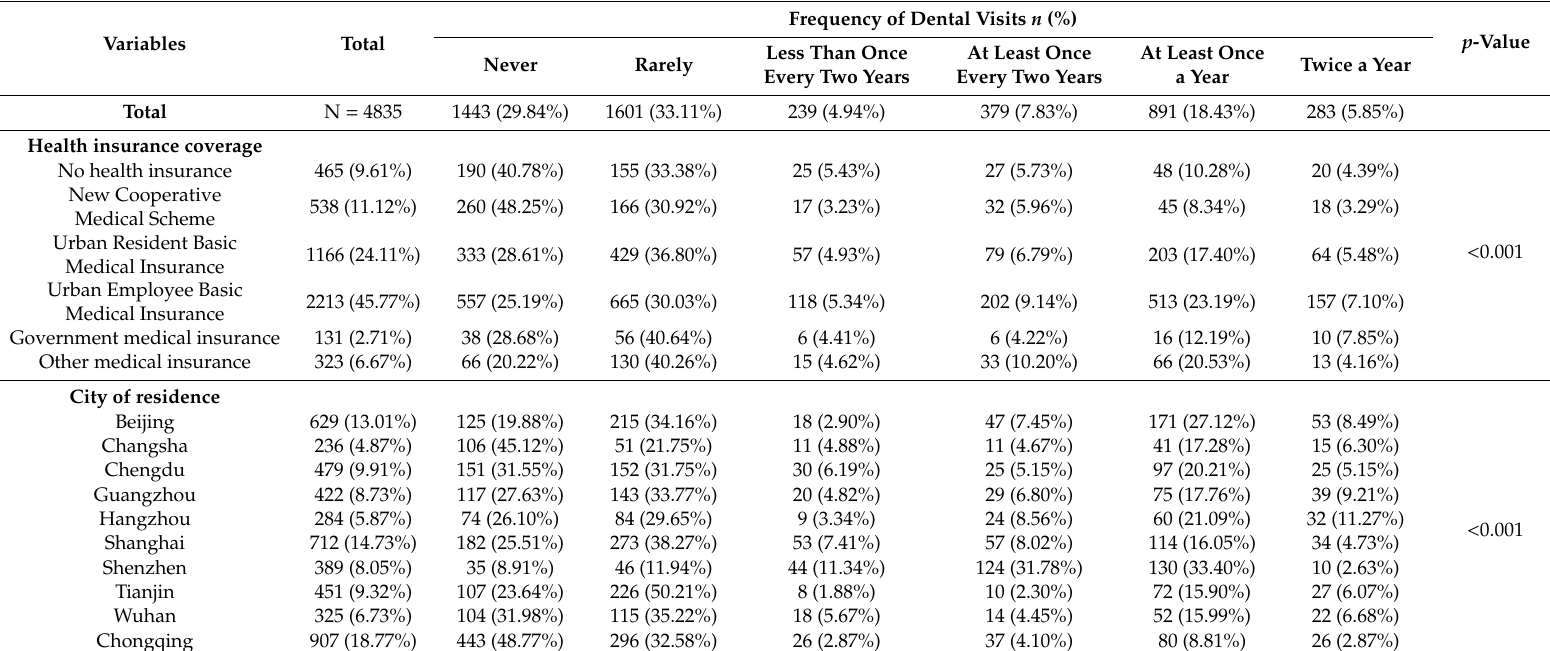
Table 2. Health insurance coverage and city of residence by dental visits (weighted).